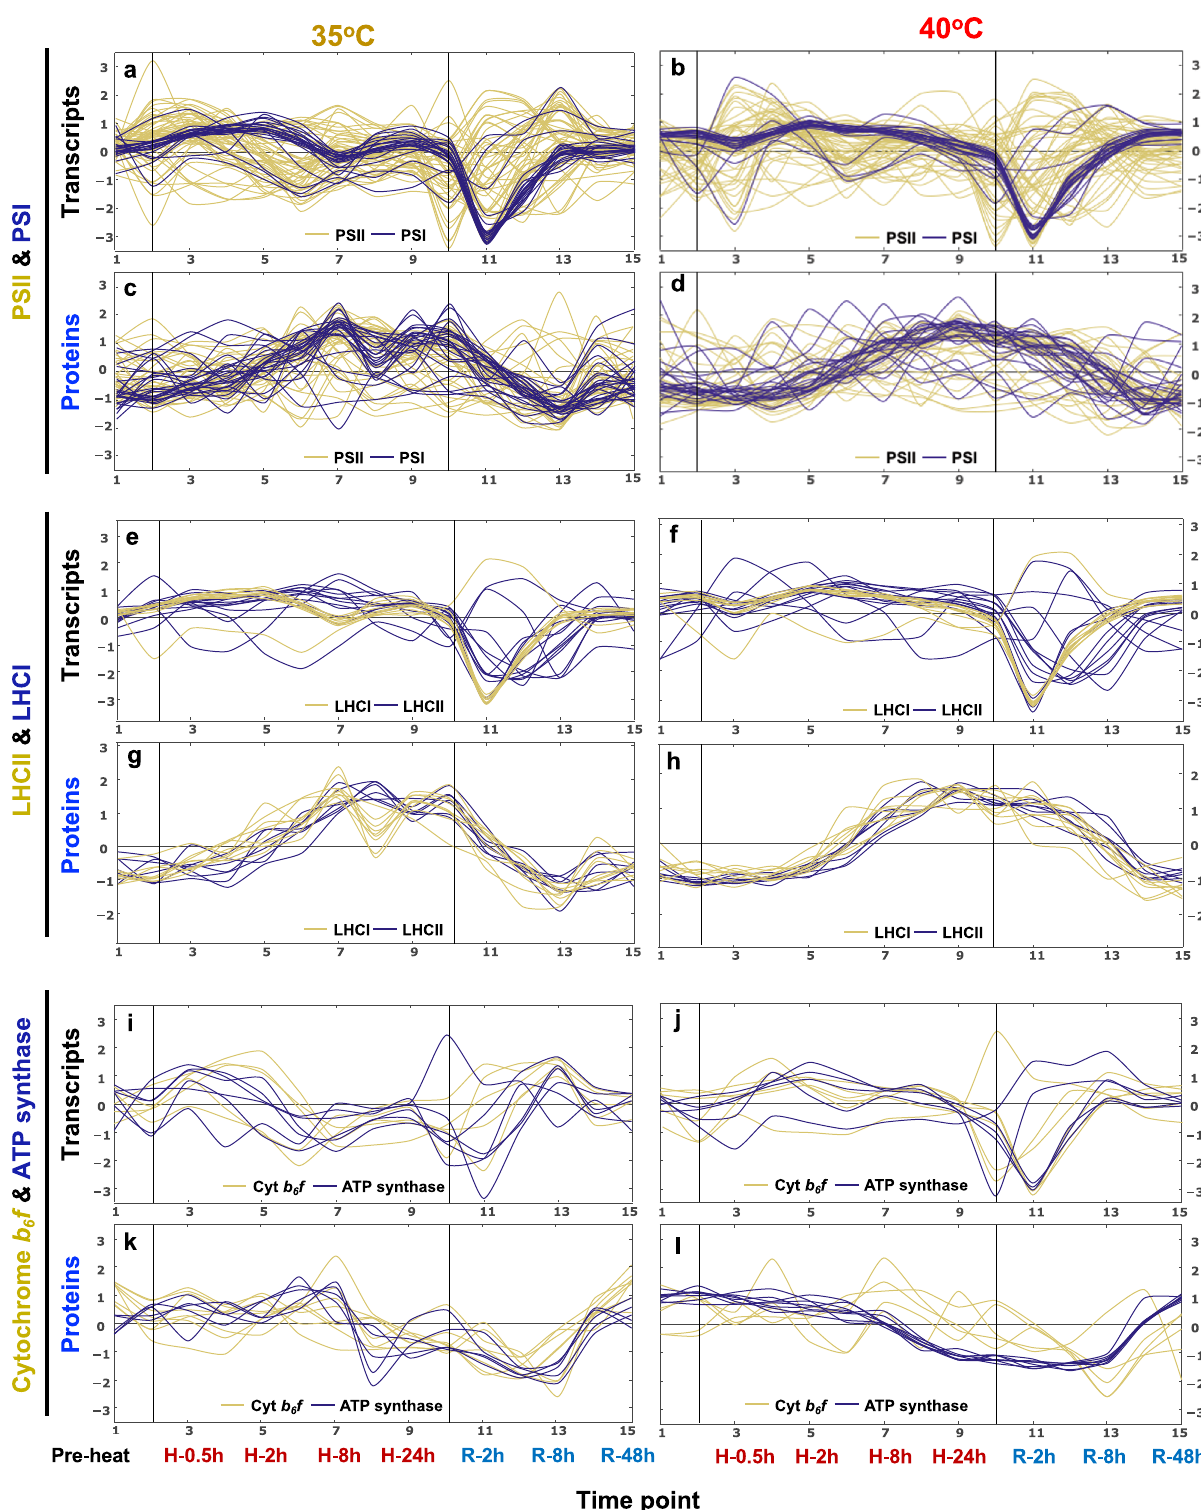
Fig. 6 Transcripts and proteins related to photosynthetic light reactions changed dynamically during and after 35°C and 40°C heat treatments. Signals of transcripts ( a , b , e , f , i , j ) and proteins ( c , d , g , h , k , l ) related to the MapMan bin photosynthetic light reactions, including PSII and PSI ( a – d ), LHCII and LHCI ( e - h ), Cytochrome b 6 f and ATP synthase ( i – l ), were standardized to z scores (standardized to zero mean and unit variance) and plotted against equally spaced time point increments. The black vertical lines indicate the start and end of heat treatments at 35°C ( a , c , e , g , i , k ) and 40°C ( b , d , f , h , j , l ), respectively. Time points are labeled at the bottom. Timepoint 1: pre-heat. Time points 2-9, heat treatment at 35°C or 40°C, including reaching high temperature (0), 0.5, 1, 2, 4, 8, 16, 24h during heat; time points 10 – 15, recovery phase after heat treatment, including reaching control temperature (0), 2, 4, 8, 24, 48h during recovery. See the interactive fi gures with gene IDs and annotations in Supplementary Data 10 (transcript/protein dynamics), the groups of PS.lightreaction (PS for photosynthesis).